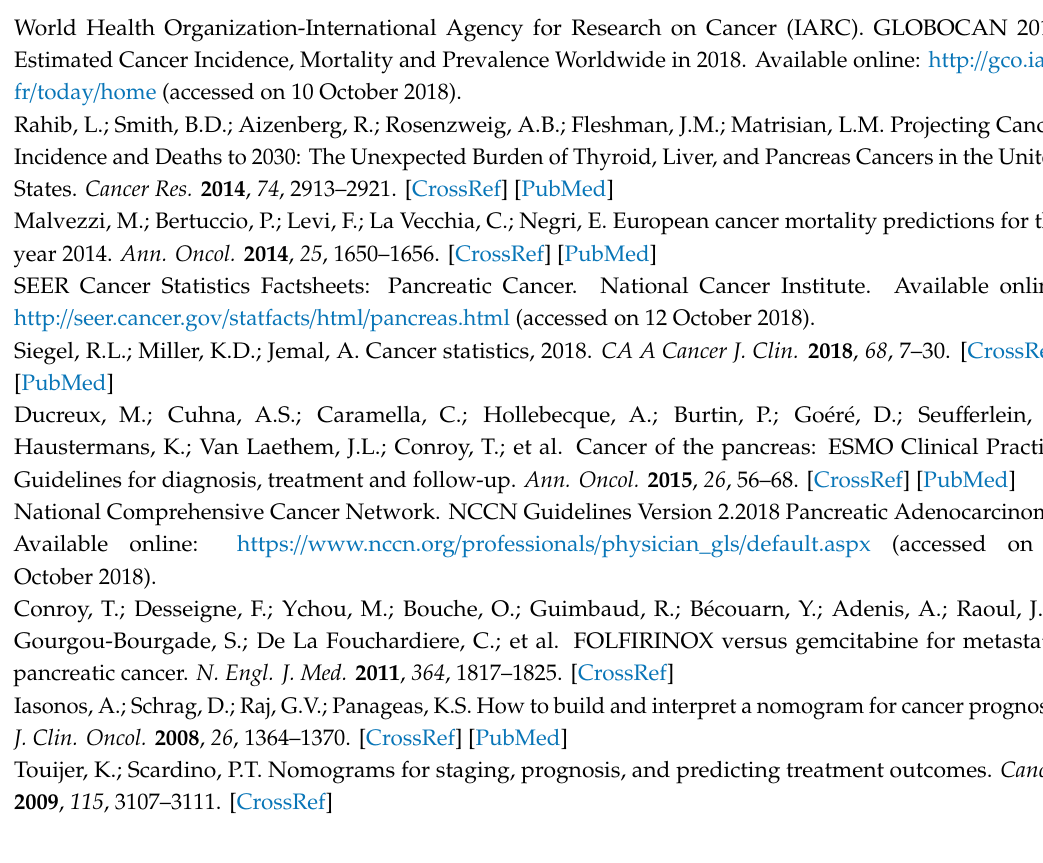
Figure S1: Kaplan-Meier survival curves showing overall survival probability stratified by treatment arm for (A) higher-risk patients, (B) medium-risk patients, and (C) lower-risk